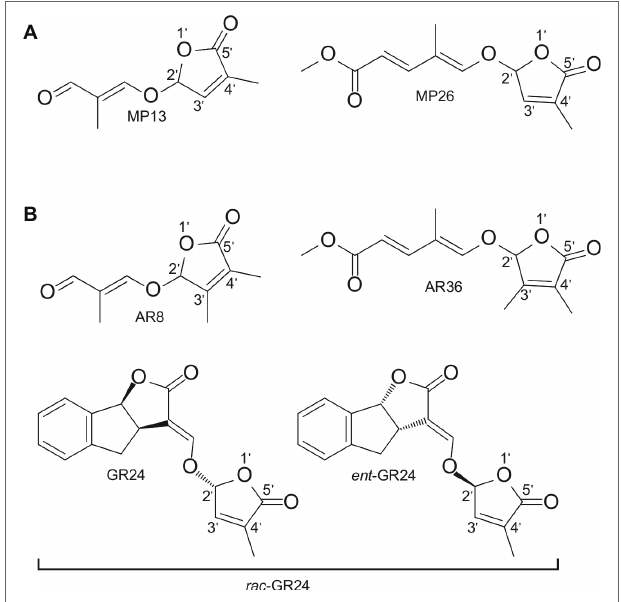
FIGURE 1 | (A) Structure of modified simple SL analogs MP13, MP26; (B) Structure of parent SL analogs AR8, AR36, and standard SL analog rac - GR24 consisting of the two shown stereoisomers. MP13 and MP26 were developed by structural modification from previously described SL analogs AR8 and AR36, respectively (Boyer et al.,